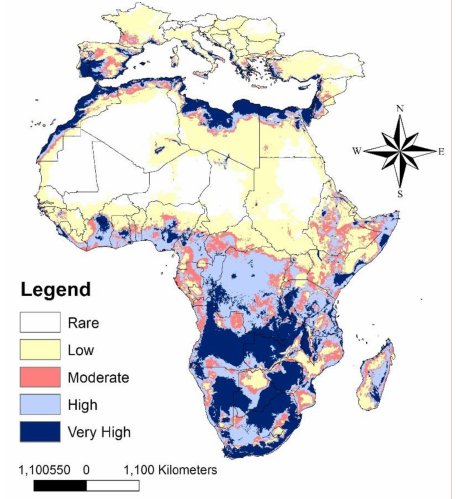
Figure 2. Current potential distribution of Oplostomus fuligineus